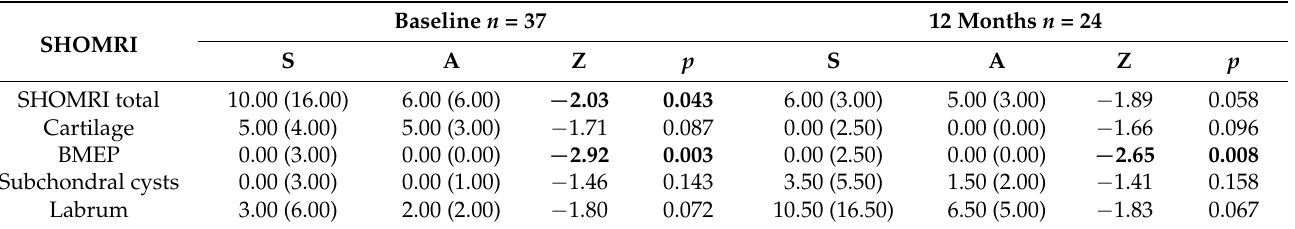
Table 4. Differences between symptomatic and asymptomatic joints in SHOMRI at baseline and 12-month